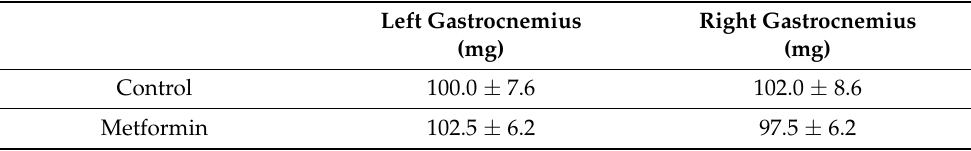
Data shown as mean ± SEM.